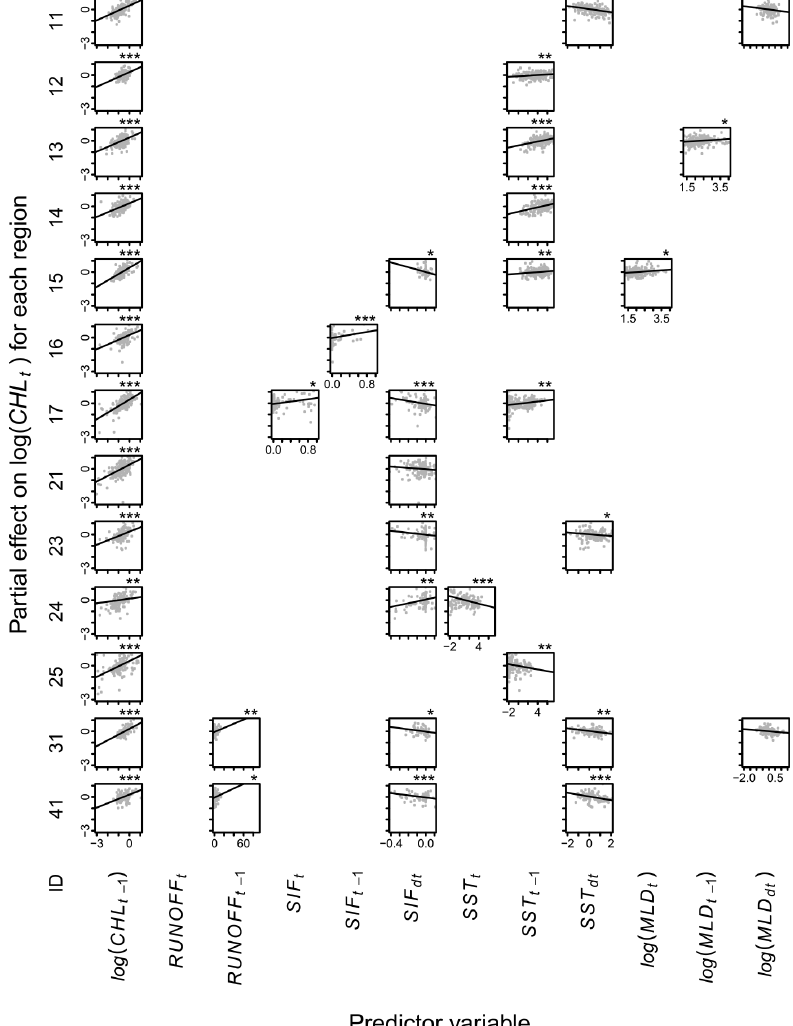
Figure A2. Partial effects of environmental variables on chlorophyll a , CHL, within 10 to 20km from the coast. Each row shows the model (Eq. 1) for one hydrological region (Table 1). Each panel shows the relationship between a predictor variable ( x axes) and CHL ( y axes), with lines showing estimated partial effects and points showing partial residuals. Blank panels imply that the variable was not selected. Asterisks show statistical significance at levels 5% ( ∗ ), 1% ( ∗∗ ) or 0.1% ( ∗∗∗ ).